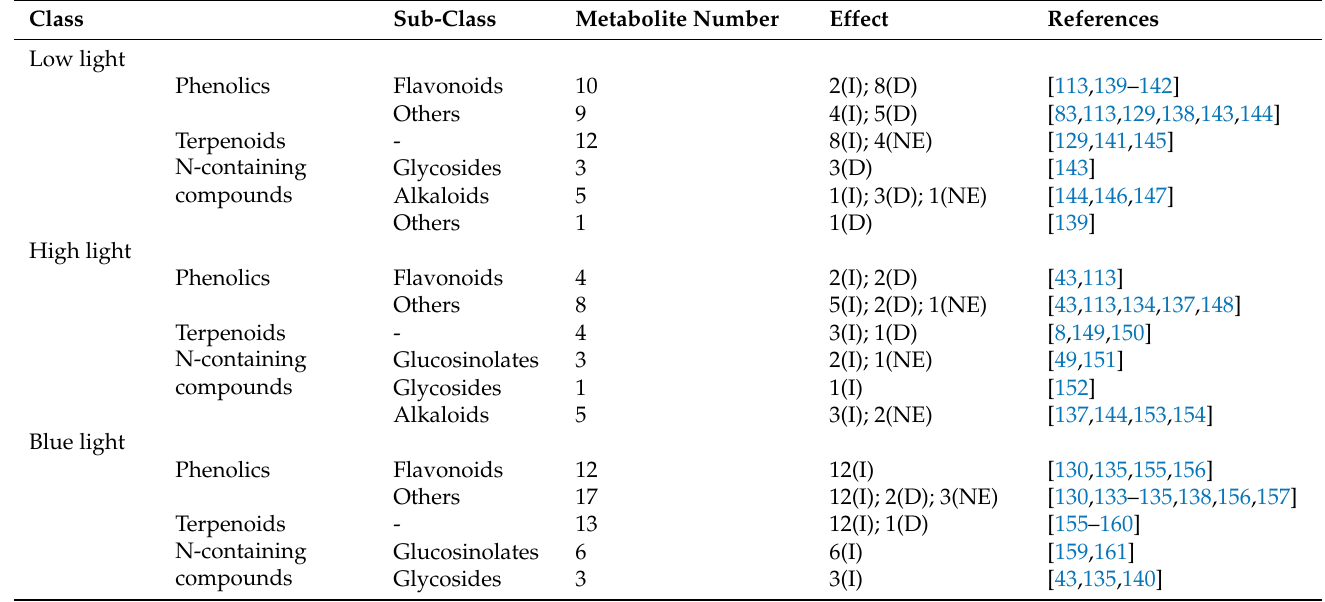
Table 4. Effects of light quantity and quality on plant secondary